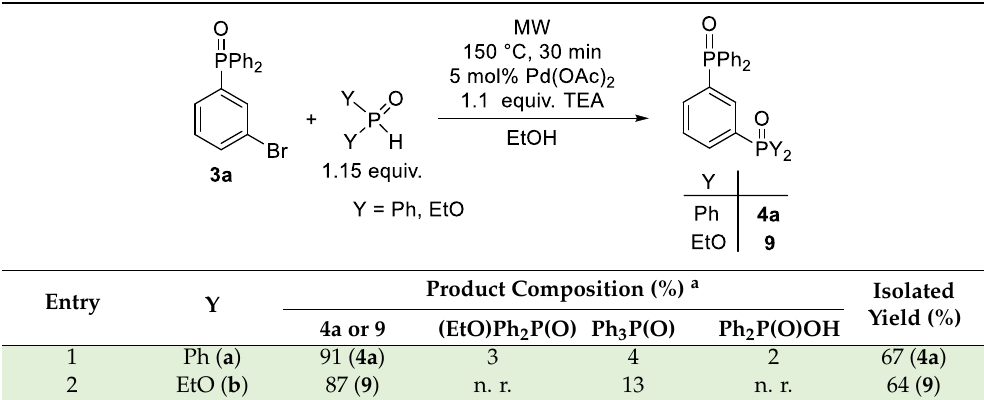
Table 9. P–C coupling reactions of 3-bromophenyl(diphenylphosphine oxide) with Ph 2 P(O)H and (EtO) 2 P(O)H reagents.